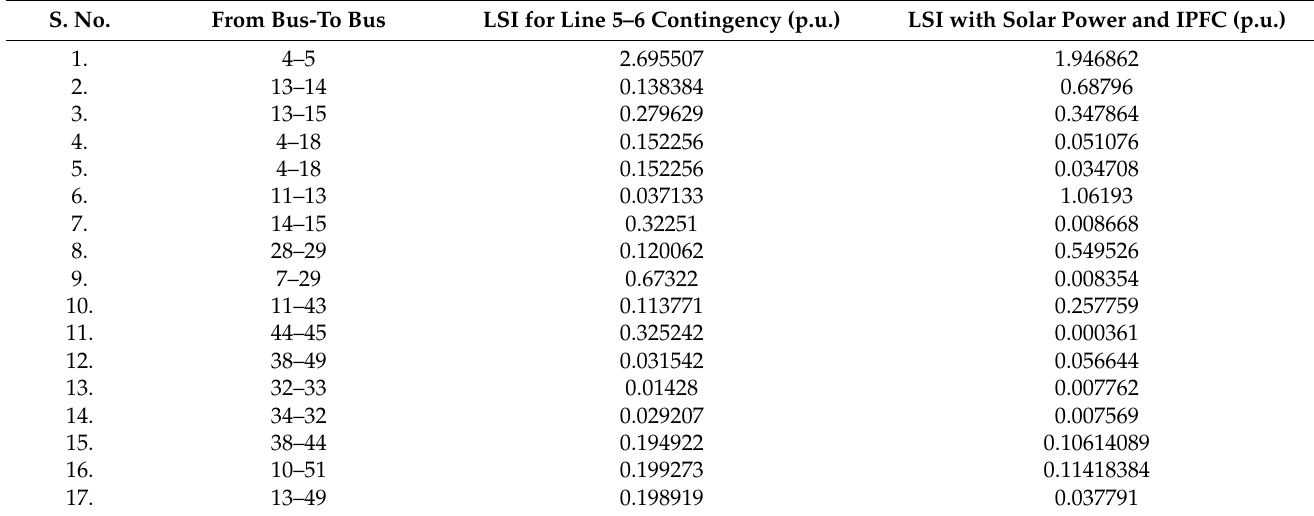
Table 4. LSI of transmission lines for lines 5–6 contingency.